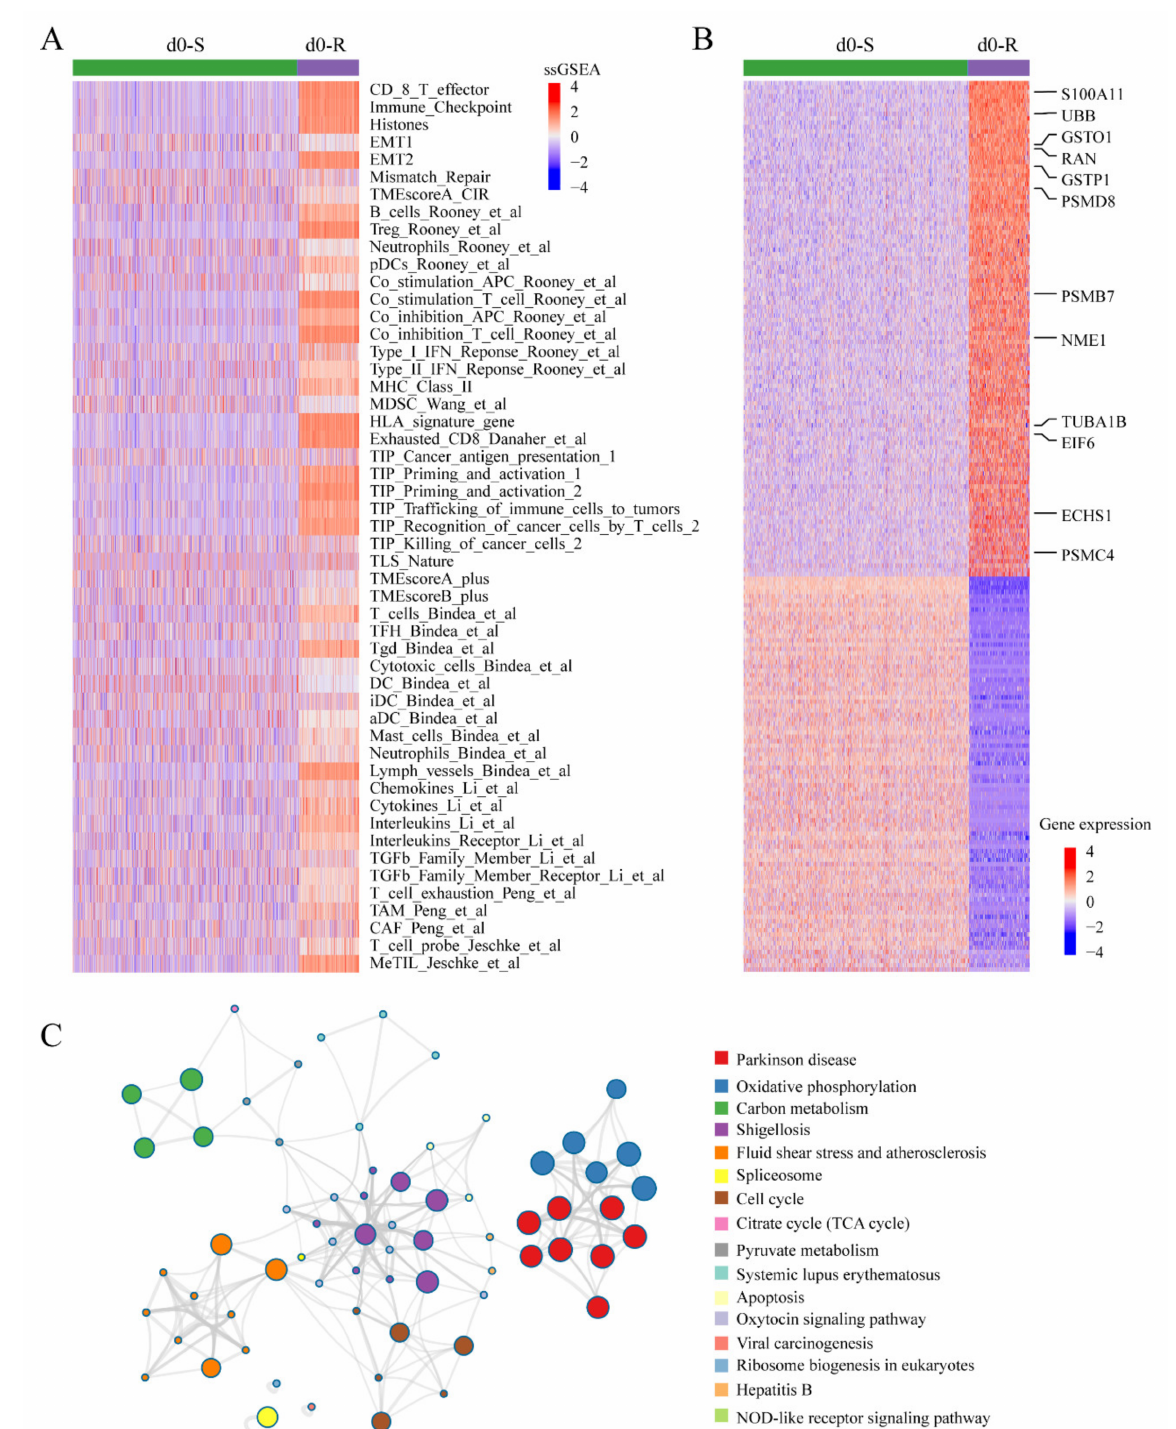
Figure 5. Functional analysis for d0-S and d0-R cells. ( A ) The heatmap shows the TME-associated signatures with significantly different ssGSEA scores between d0-R and d0-S cells. ( B ) The heatmap shows differentially expressed genes between d0-R and d0-S cells. ( C ) Enrichment map of KEGG pathways for the upregulated genes in cluster d0-R. The node size represents the number of genes in a pathway. The edge width represents the similarities between two